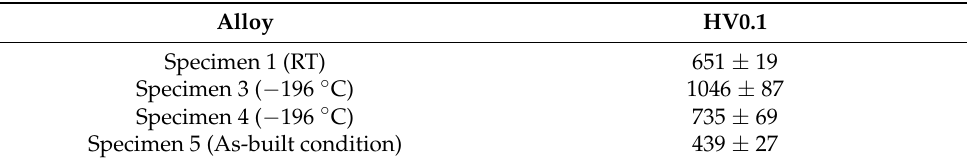
Table 5. Microhardness of L-PBF 316